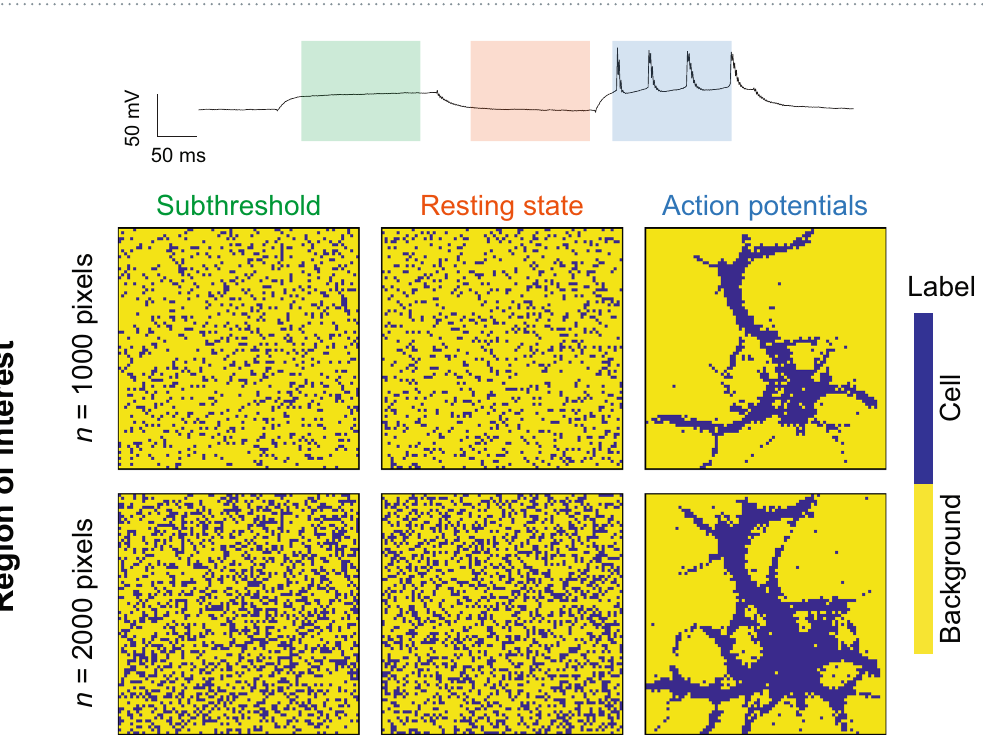
Figure 8. Defining regions of neuronal activity with an electrode-free method for Bongwoori-R3. Top, electrical recording of the neuron expressing Bongwoori-R3 from Fig. 7. Color-shaded boxes correspond to different time windows used for the correlation analyses. Bottom, regions of interest computed during the subthreshold, resting state, and action potentials for an arbitrary number n = 1000 pixels or n = 2000